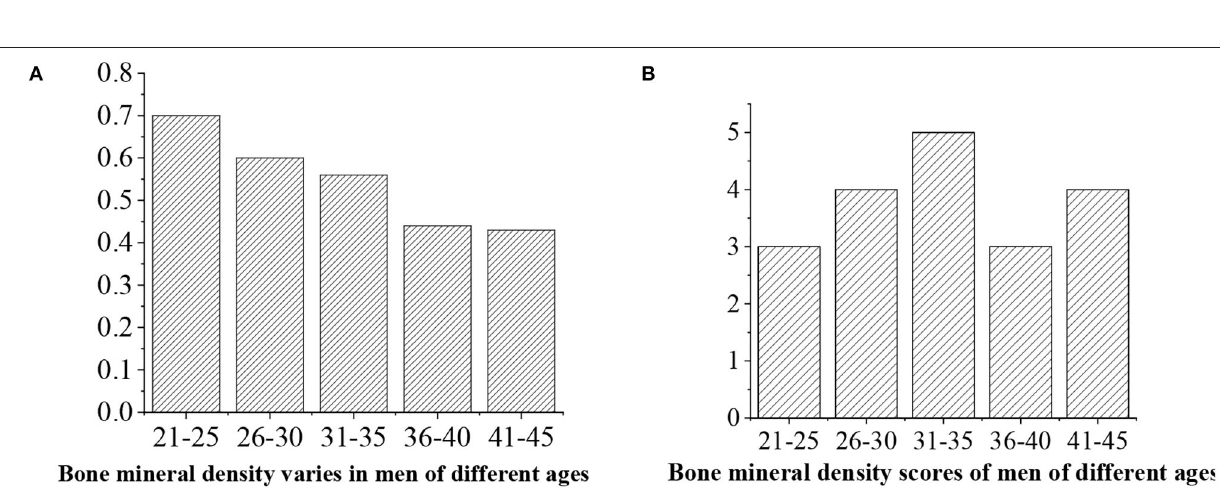
Frontiers in Public Health |